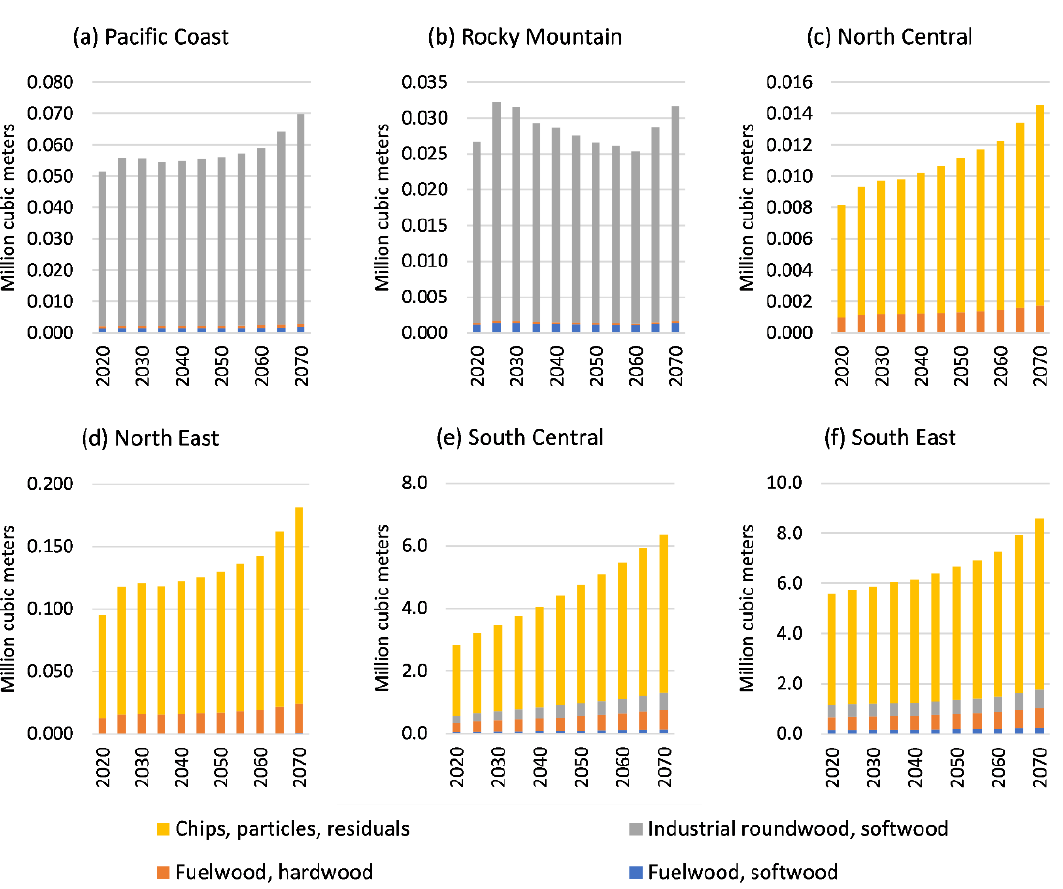
Figure 15. United States wood pellet feedstock by region and type, SSP2, projections from FOROM: ( a ) Pacific Coast, ( b ) Rocky Mountain, ( c ) North Central, ( d ) North East, ( e ) South Central, ( f ) South East.